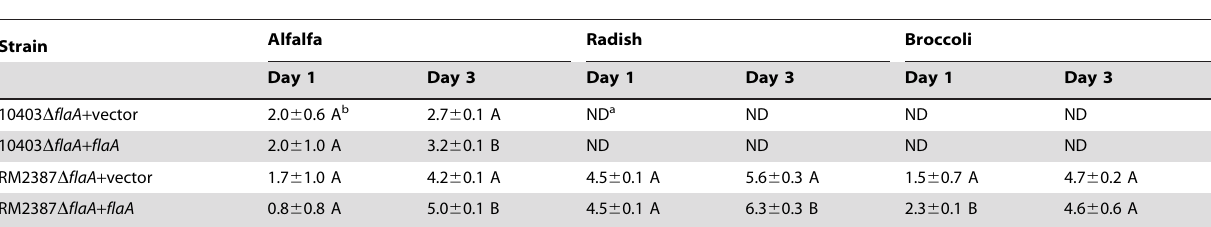
Table 2. Complementation of affected flaA mutants on sprouts.